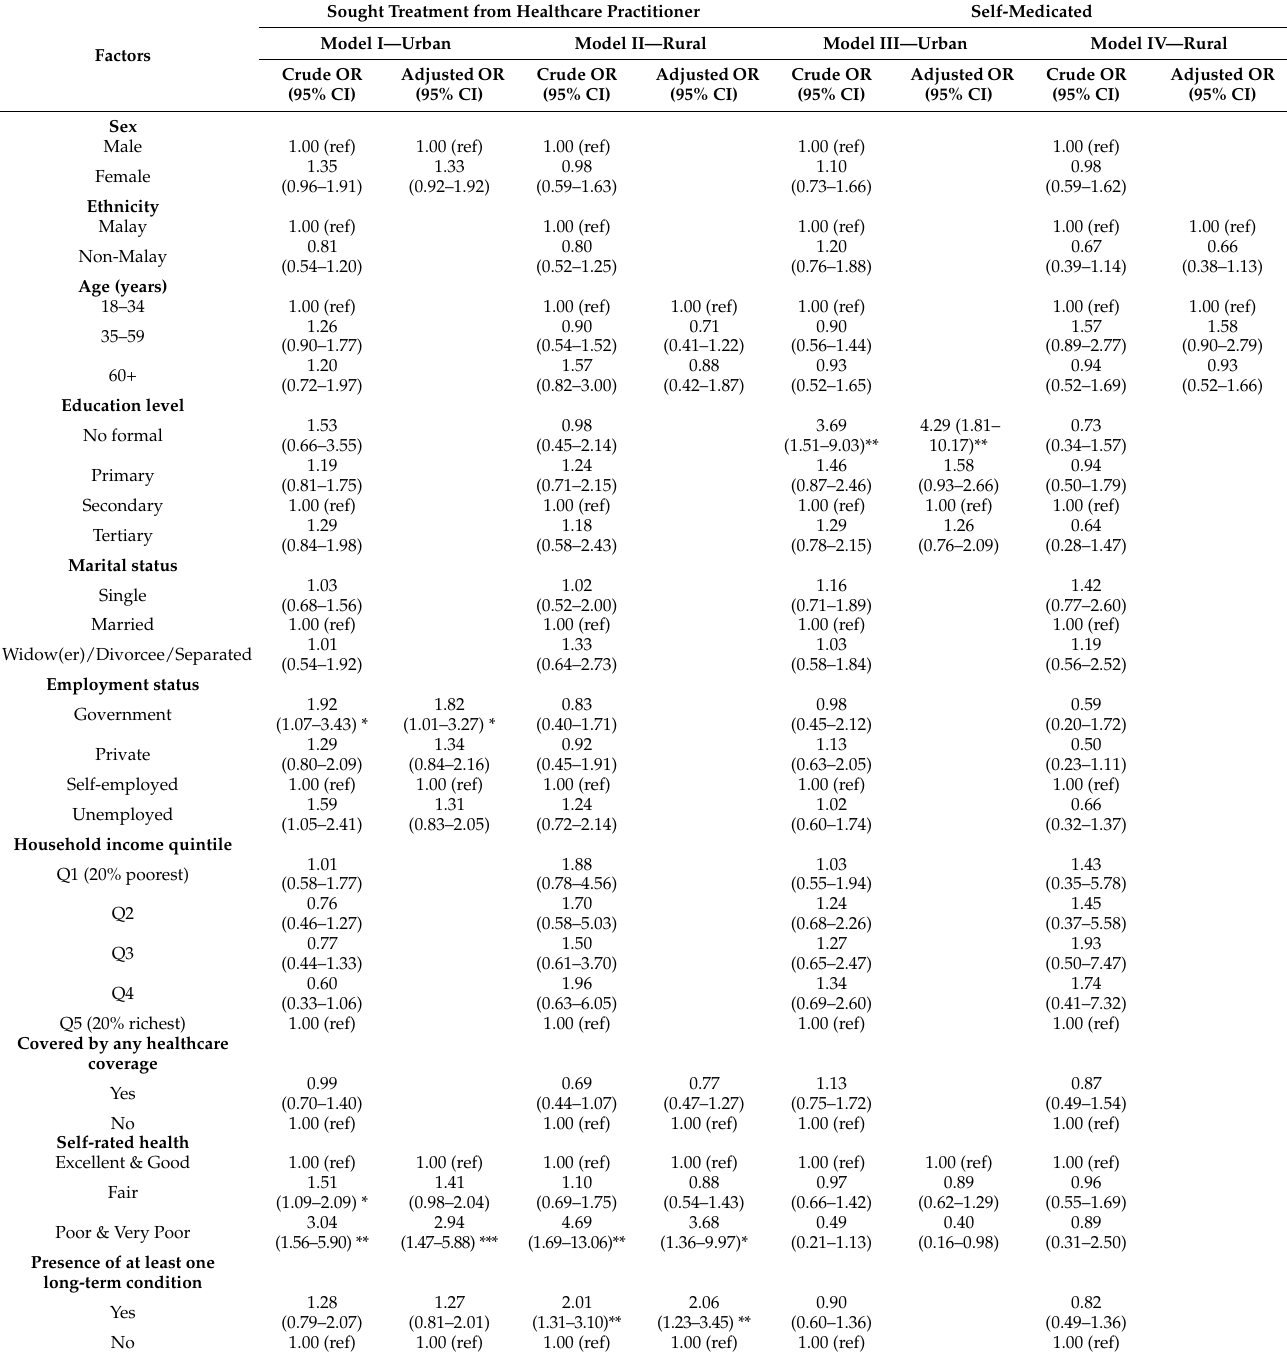
Table 3. Logistic regression model for health-seeking behaviors among Malaysian adults who reported sickness, stratified by urban-rural